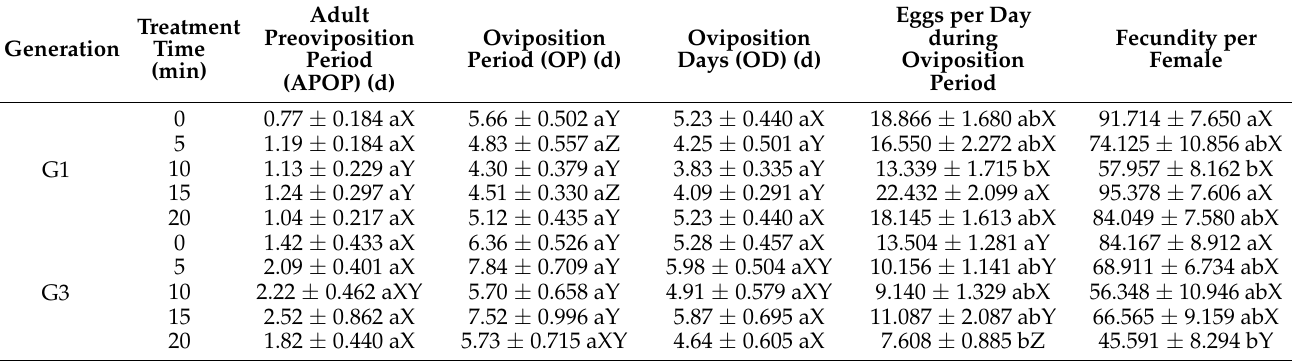
Figure 5. Age-specific survival rates ( l x ) at each life stage of the first, third, and fifth generations of P. xylostella, with 5 consecutive generations treated with HVEF at 5.0 kV/cm for 0, 5, 10, 15, and 20 min. For each generation, the control group received 0 min of treatment. ( A , D , G , J , M ) The first column represents the survival rate of each stage at 0, 5, 10, 15, and 20 min for the first generation. ( B , E , H , K , N ) The second column represents the survival rate with each treatment time for the third generation. ( C , F , I , L , O ) The last column represents the survival rate of the fifth generation after HVEF stress at each stage. Table 2. Fecundity parameters of each generation under different treatment